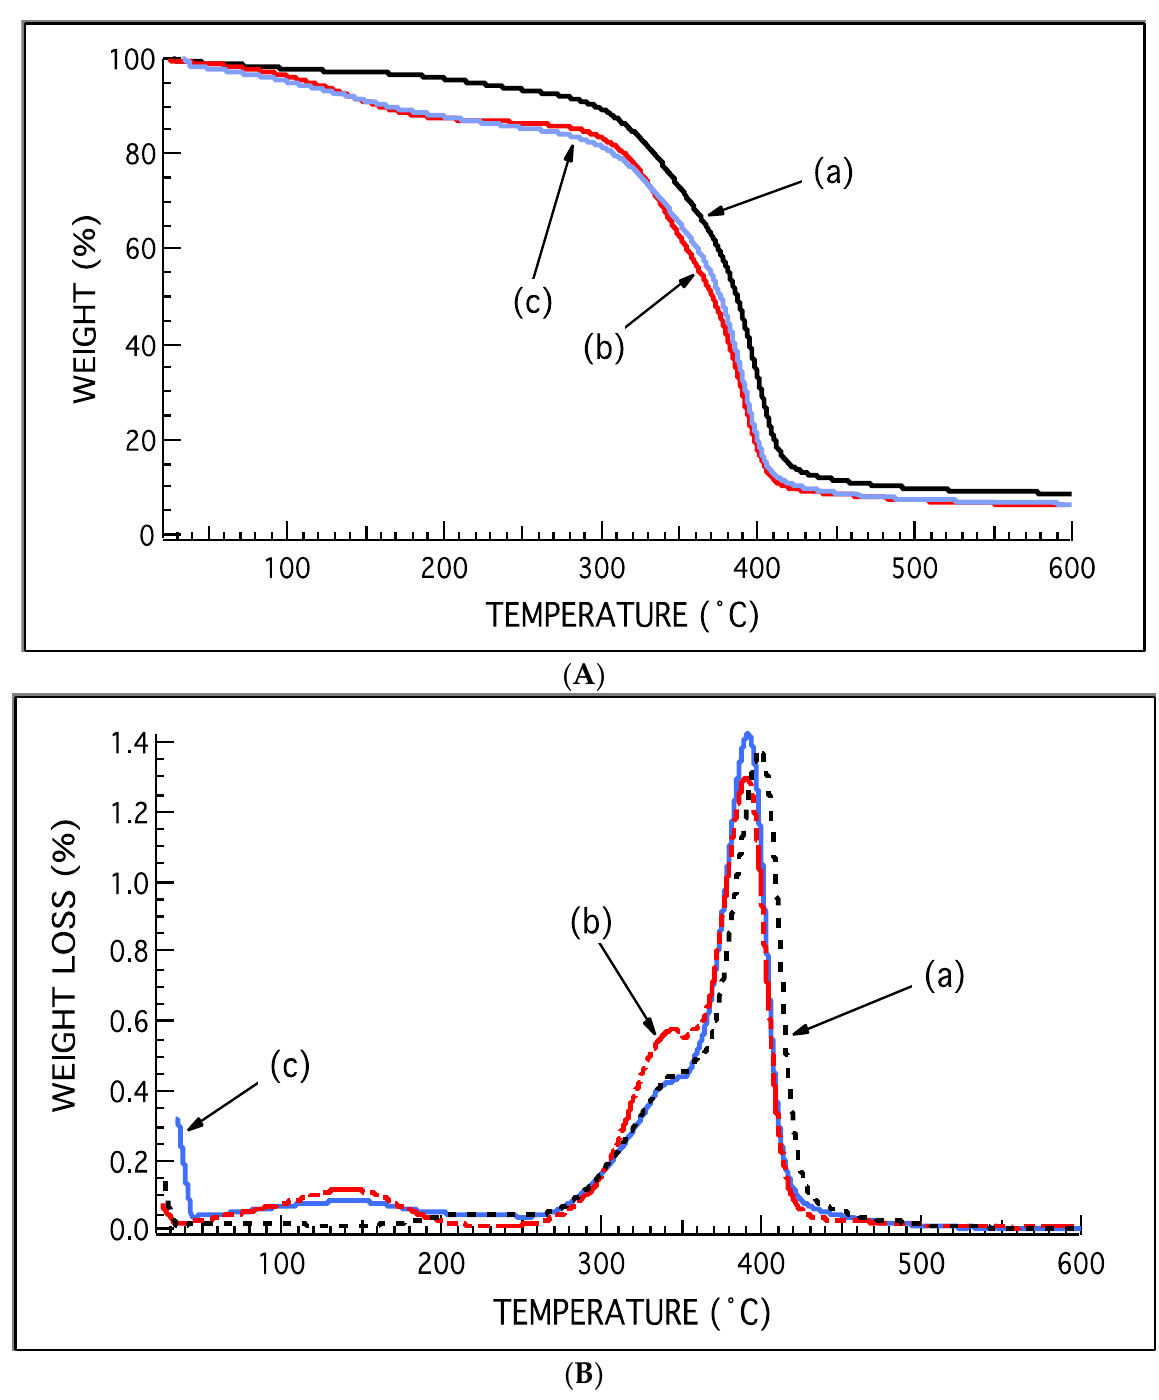
Figure 10. ( A ) Comparison of the TGA weight loss of: (a) epoxy/microcapsule composite after DMA test; (b) neat epoxy; (c) epoxy/microcapsule composite. ( B ) Comparison of derived weight of: (a) epoxy/microcapsule composite after DMA; (b) neat epoxy; (c) epoxy/microcapsule composite.